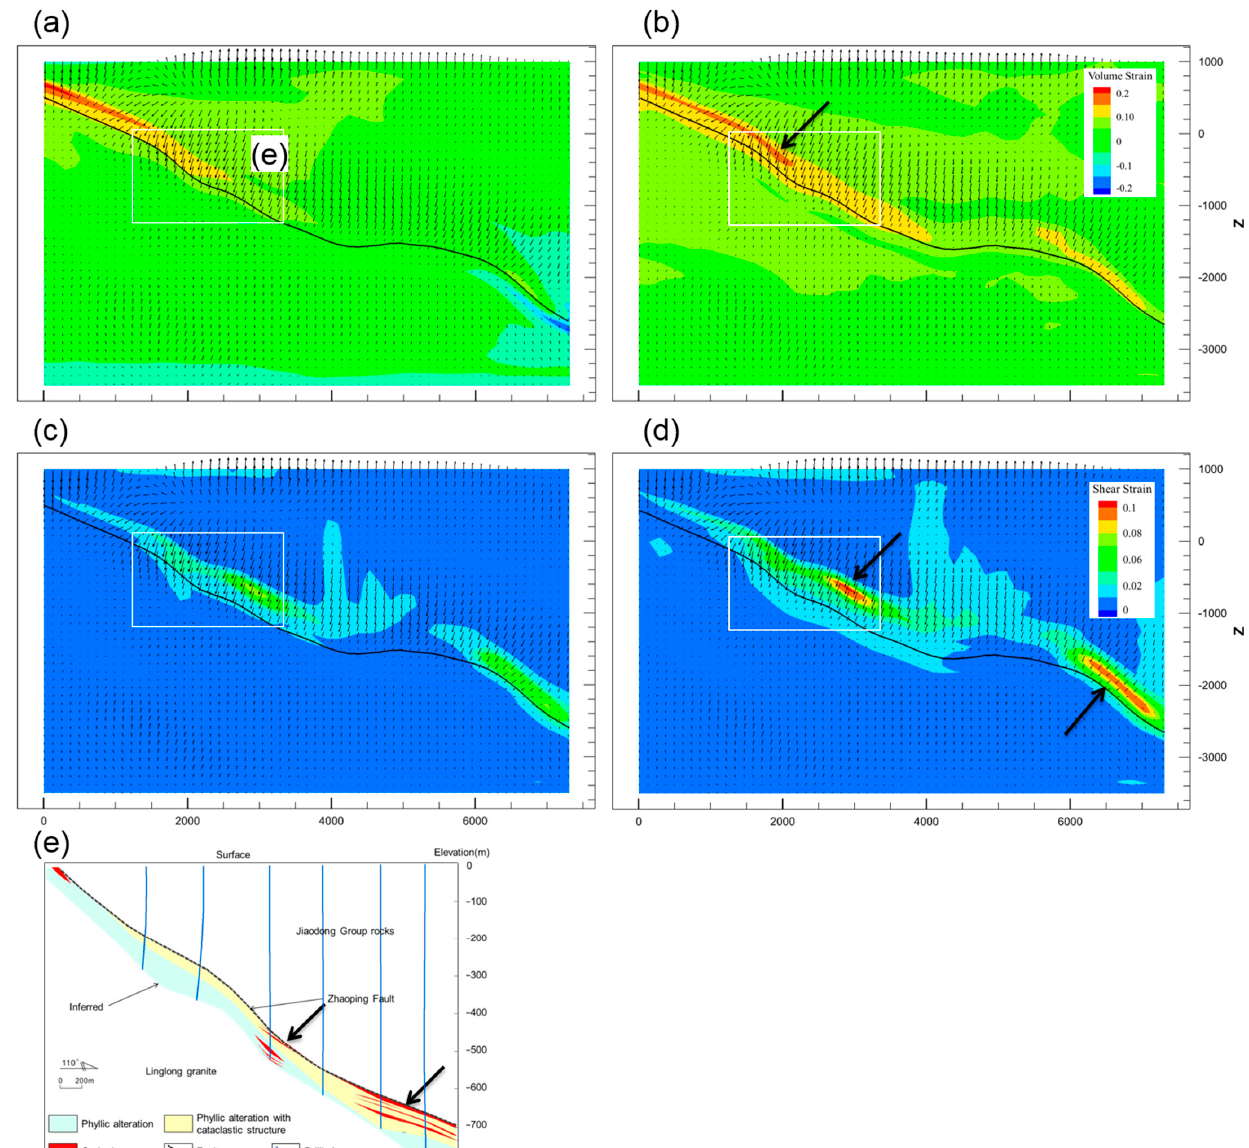
Figure 7. The volumetric strain, shear strain distribution, and detailed fluid flow vectors at a strain rate of 10 − 11 s − 1 . In the figure, the rectangular box is the scope of the cross-sections; thick arrows indicate areas of intense strain or mineralization; the vector arrows represent the Darcy flux and are used to indicate the direction of flow. ( a ) 0.5% volumetric strain, ( b ) 1.0% volumetric strain, ( c ) 0.5% shear strain, ( d ) 1.0% shear strain, and ( e ) corresponding geological